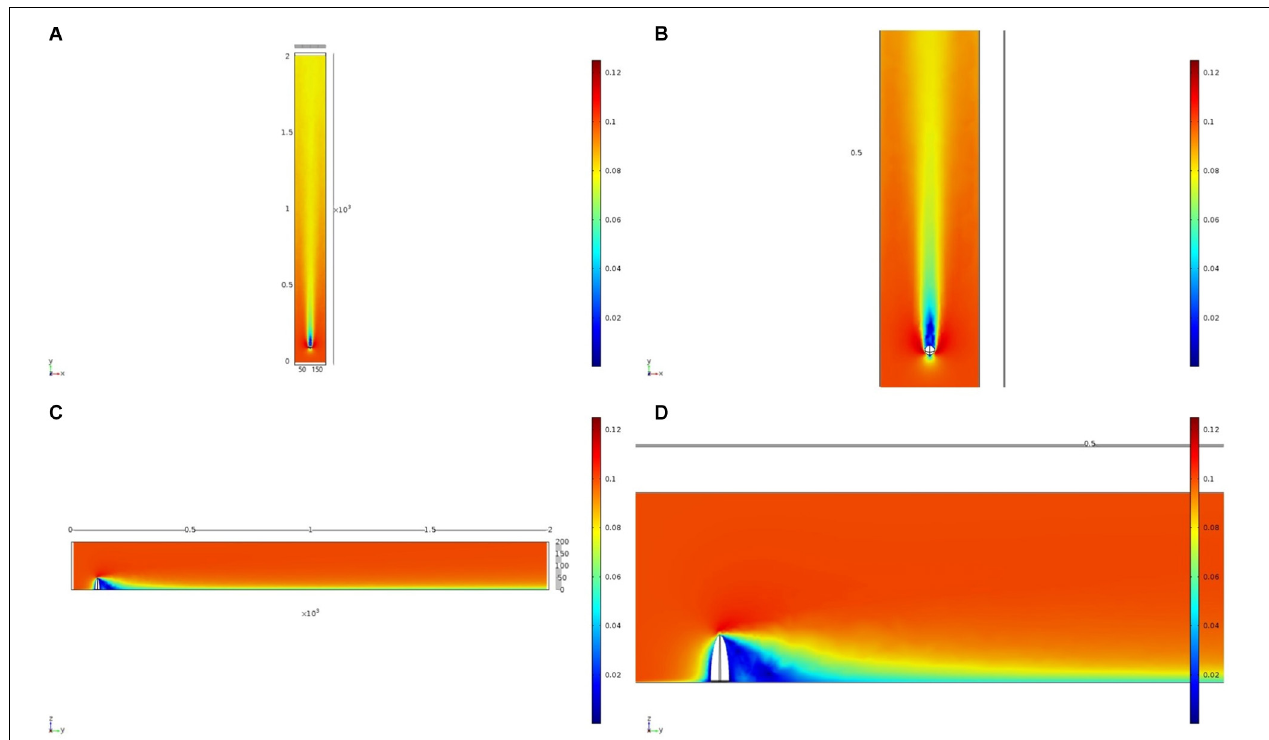
FIGURE 5 | Results of the fluid flow finite element analysis simulation for an idealized ellipsoid, visualized as two-dimensional plots [horizontal (A,B) and vertical (C,D) cross sections] of flow velocity magnitude (false-color scales m/s). Scale in mm with ambient flow of 0.1 m/s along the y -axis. (B,D) Zoom in on the wake close to the